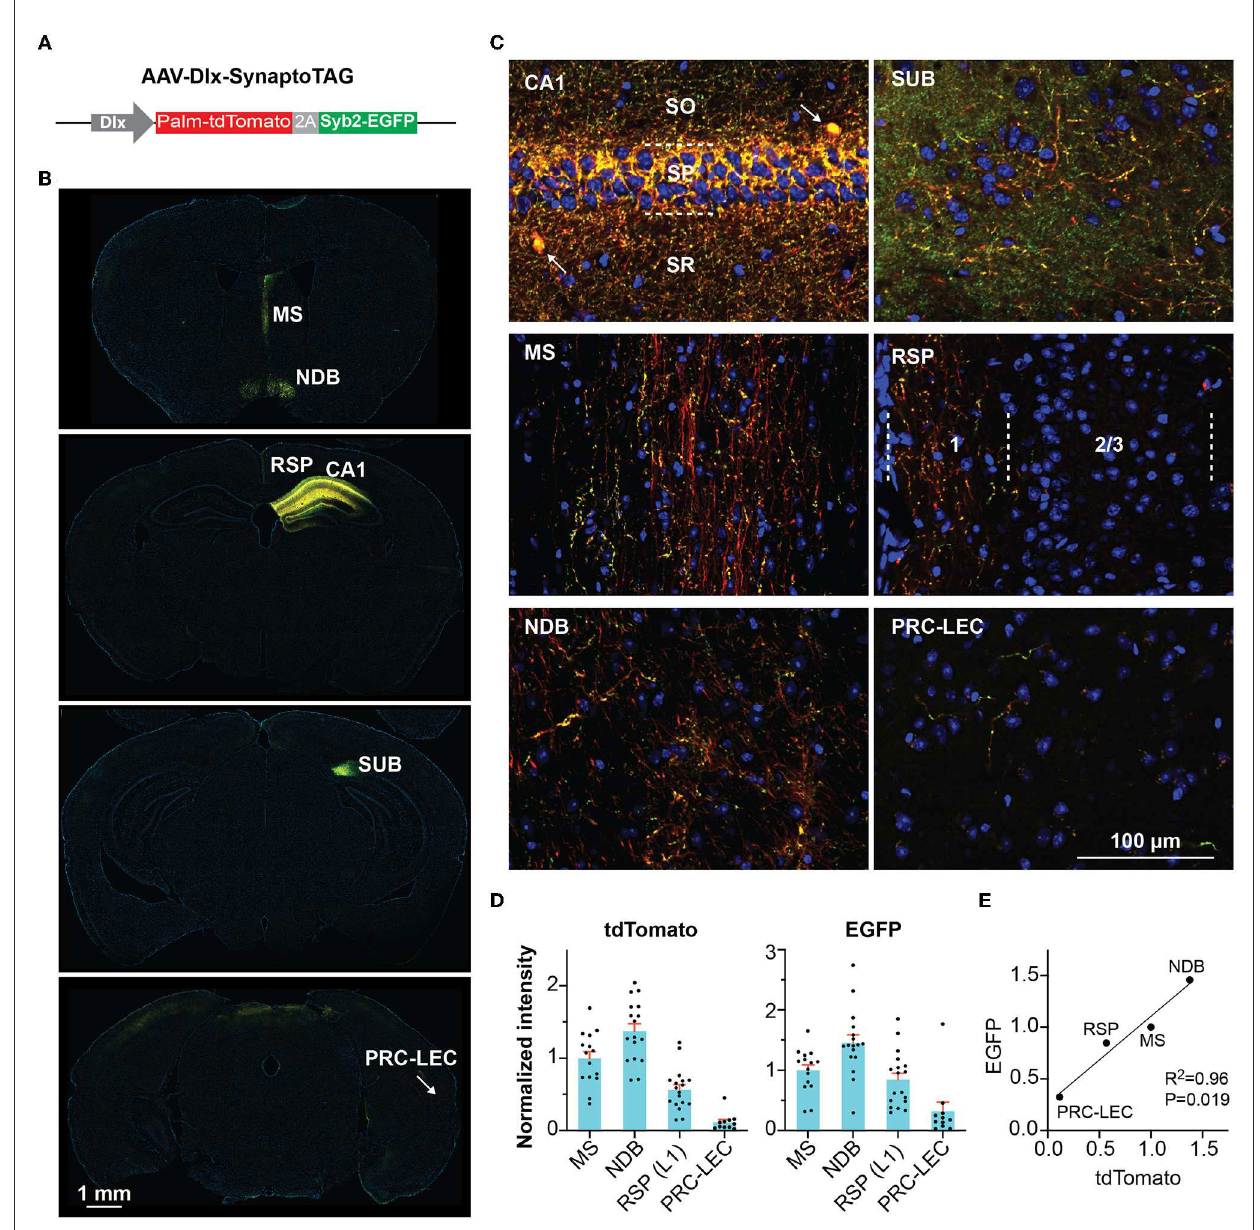
FIGURE1 Tracing GABAergic outputs from the hippocampal CA1 region. (A) Design of AAV-Dlx-SynaptoTAG. (B, C) Low- and high-resolution representative images showing the Palm-tdTomato-positive axons and EGFP-positive boutons in the respective brain regions. The axons and boutons from CA1 GABAergic neurons were detected at the hippocampus, subiculum (SUB), medial septum (MS), and nucleus of the diagonal band (NDB), and the superficial portion of layer 1 of the retrosplenial area (RSP), and the transition area between the perirhinal cortex and the entorhinal cortex (PRC-EC). (D) Quantification of the fluorescence intensities in the different brain regions. The intensities were measured from 11 to 17 sections for each region from four mice. Data are represented as mean ± SEM (E) Correlation between the averaged intensities of EGFP and tdTomato measured in the brain